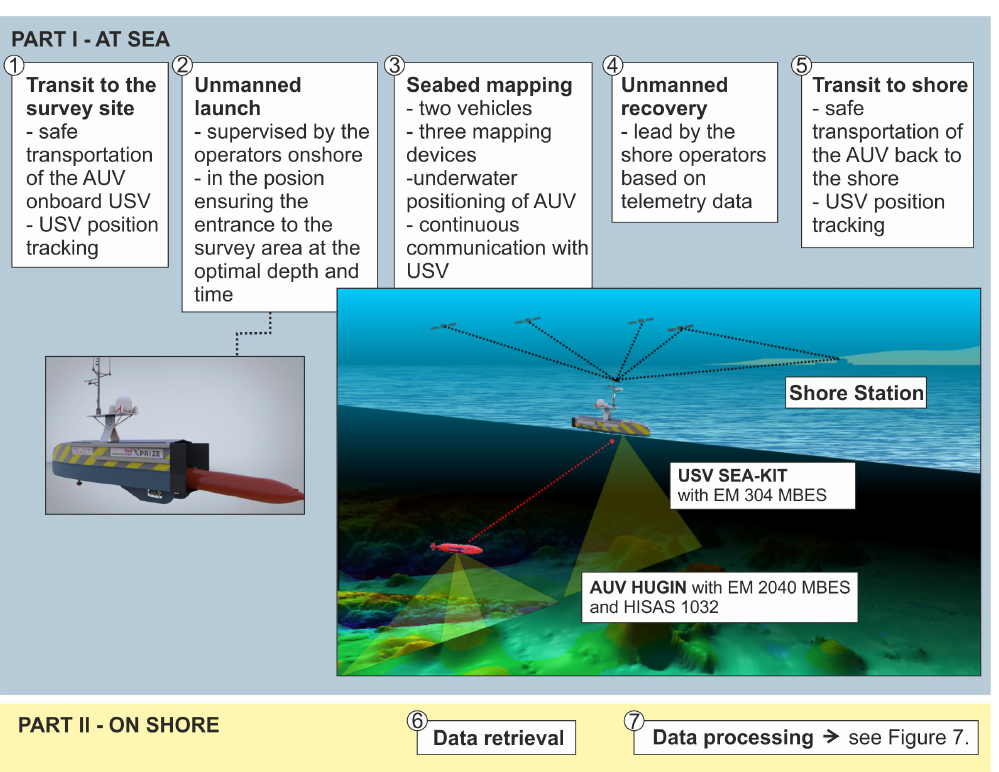
Figure 3. The scheme of the survey process including the main stages and their crucial